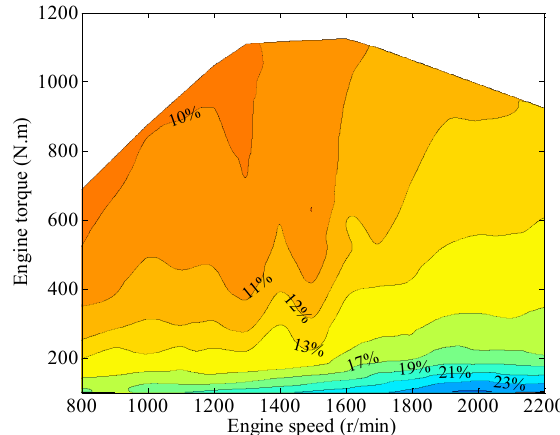
Figure 15. The distribution map of the BIR under the CNG engine test